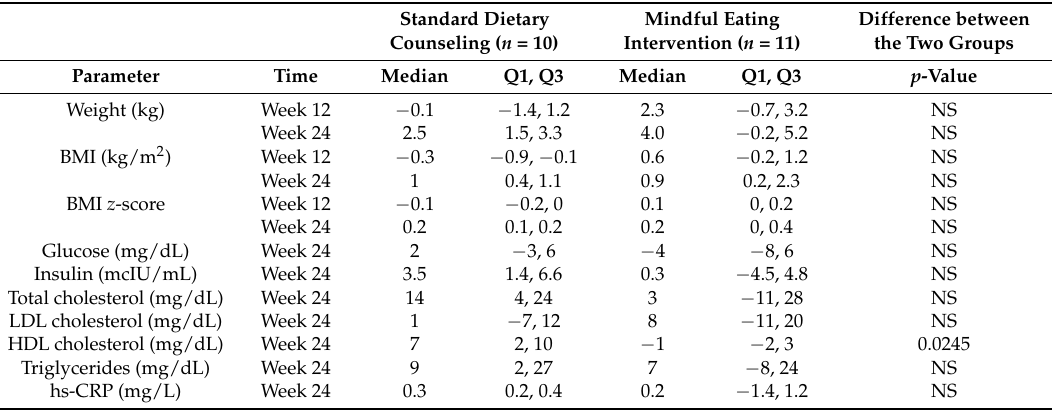
Table 2. Change in anthropometric and laboratory measures during follow up.